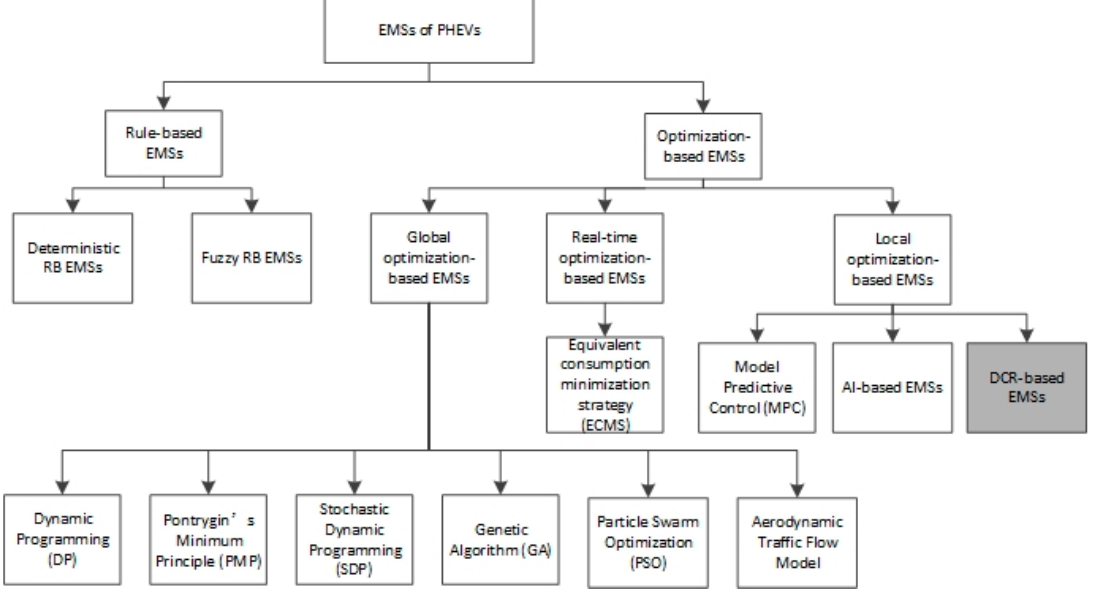
Figure 1. The framework of EMSs.